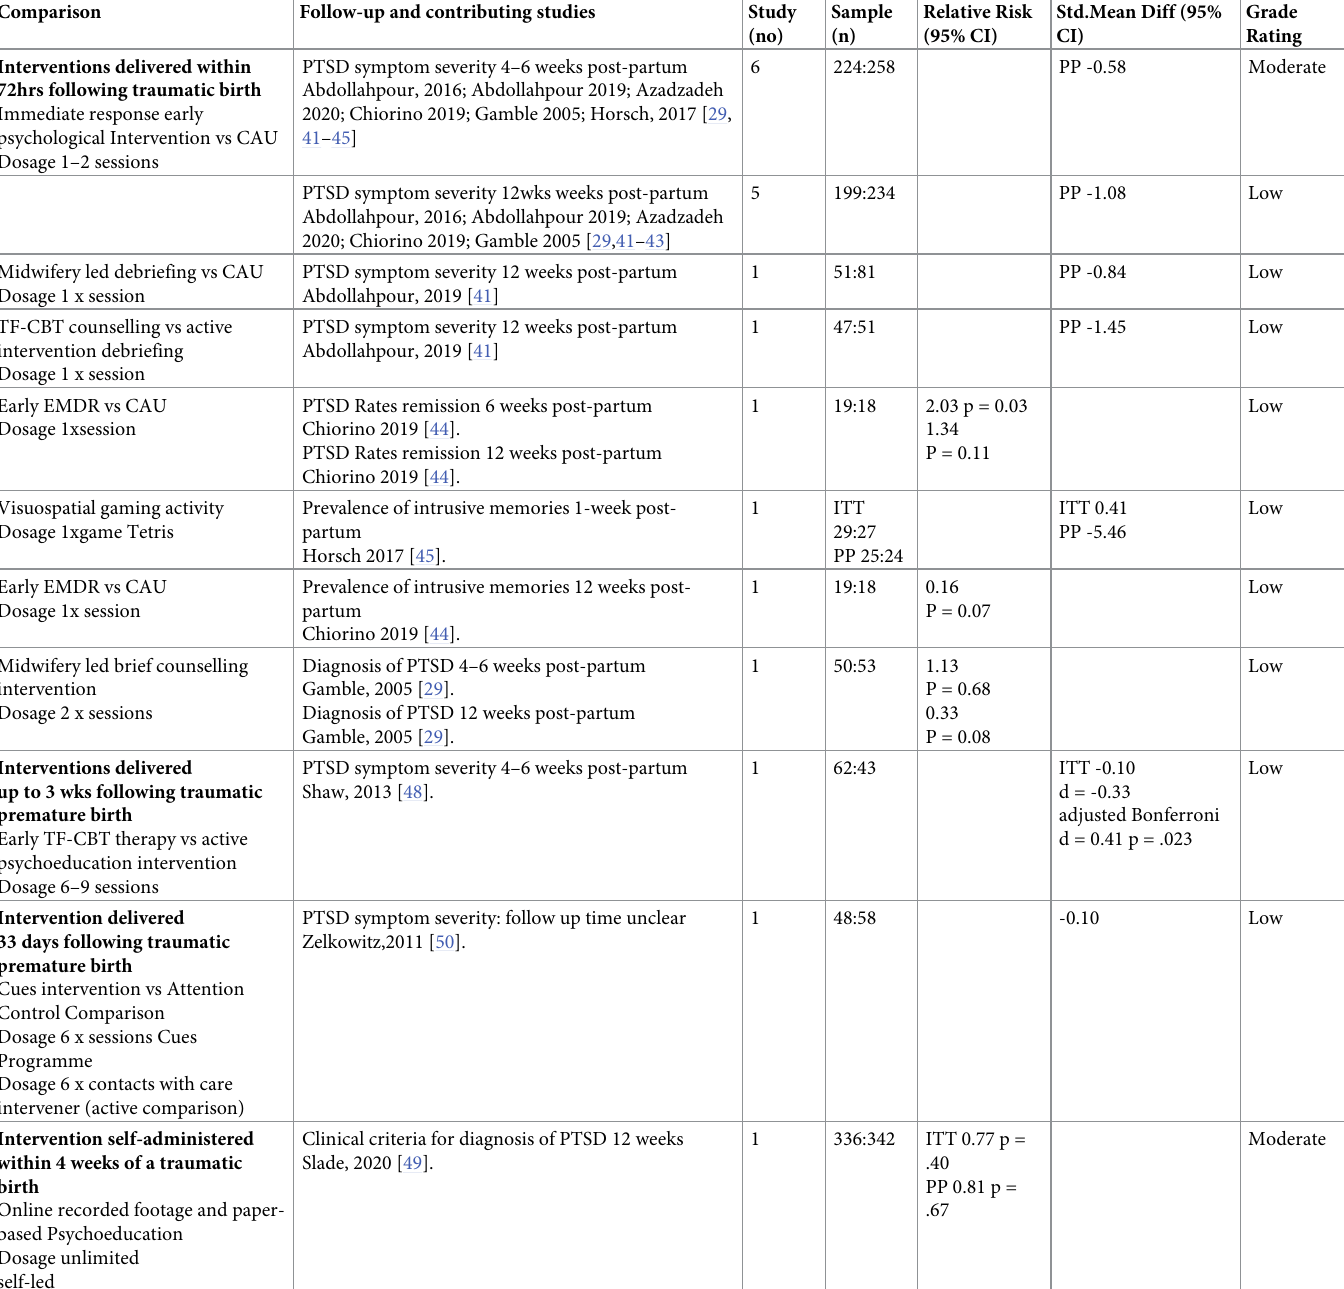
Table 4. Summary of meta-analysis. Table of results for early interventions administered within one month of exposure to a traumatic birth.